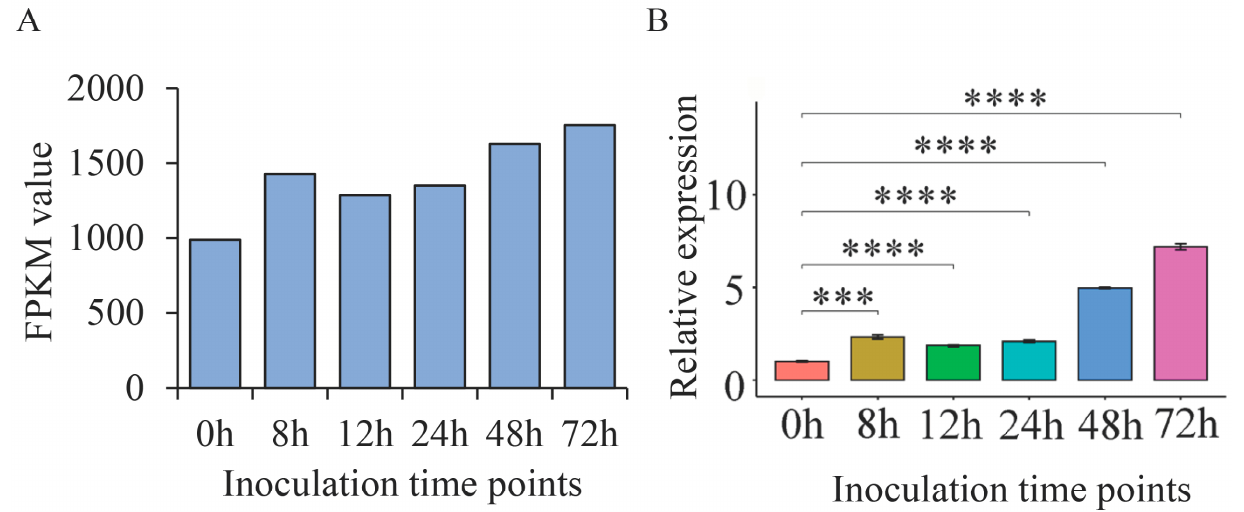
Figure 7. Expression of ThSCSP_12 during Tilletia horrida infection of the kernel smut–susceptible rice cultivar 9311A. ( A ) The transcriptome data. ( B ) The qRT-PCR analysis of ThSCSP_12. Rice kernels inoculated with Tilletia horrida were collected at 8, 12, 24, 48, and 72 hpi (hours post-inoculation) for gene expression analyses using qRT-PCR. UBQ expression was used as an internal reference for normalizing expression levels within the samples. Statistical analysis was performed by one-way ANOVA, followed by Tukey’s multiple comparison test. Error bars are the standard deviation (SD) of four independent replicates (*** p < 0.001; **** p < 0.0001).